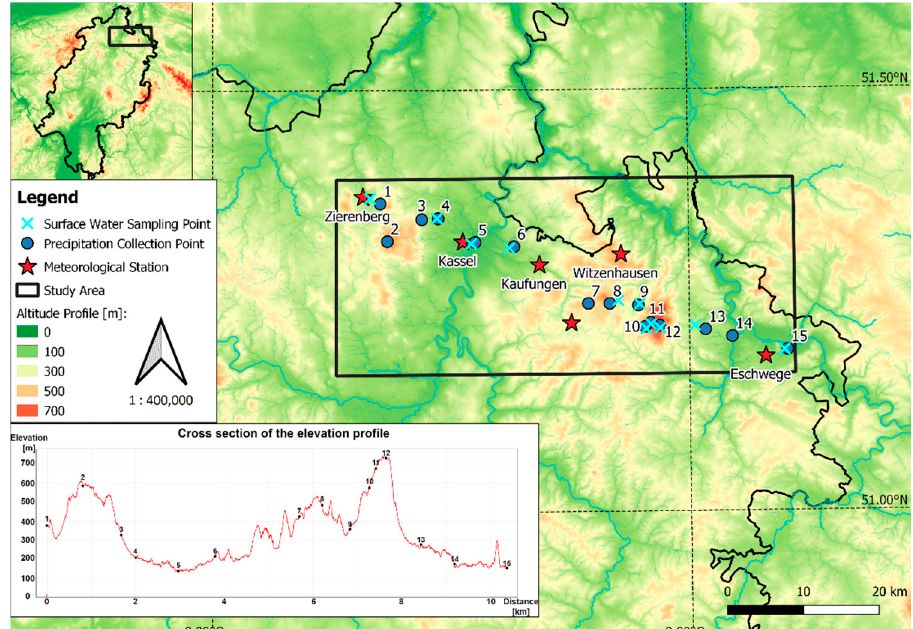
Figure 1. A map of sampling locations of precipitation and surface water along an elevation transect and respective meteorological stations in North Hesse, Germany. The elevation profile through all the precipitation collection points is presented in the bottom left corner.